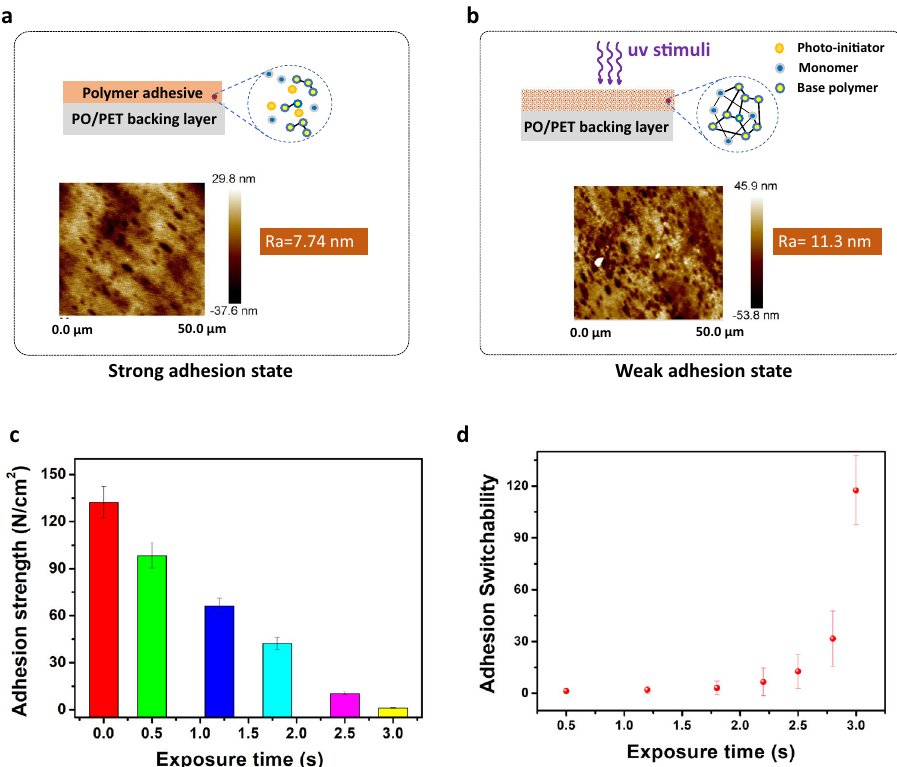
Fig. 1 Characteristics of the photosensitive polymer with switchable adhesion. a Schematic of the initial strong adhesion state of the polymer without light irradiation (Top), and AFM surface morphology of the adhesive, showing a relatively low surface roughness. b Schematic of the weak adhesion state due to the light-induced solidi fi cation (top), and AFM image of the polymer surface after UV light irradiation, showing increased surface roughness. c Adhesion strength of the photosensitive polymer as a function of the UV exposure time. d Adhesion switchability of the polymer as a function of the exposure